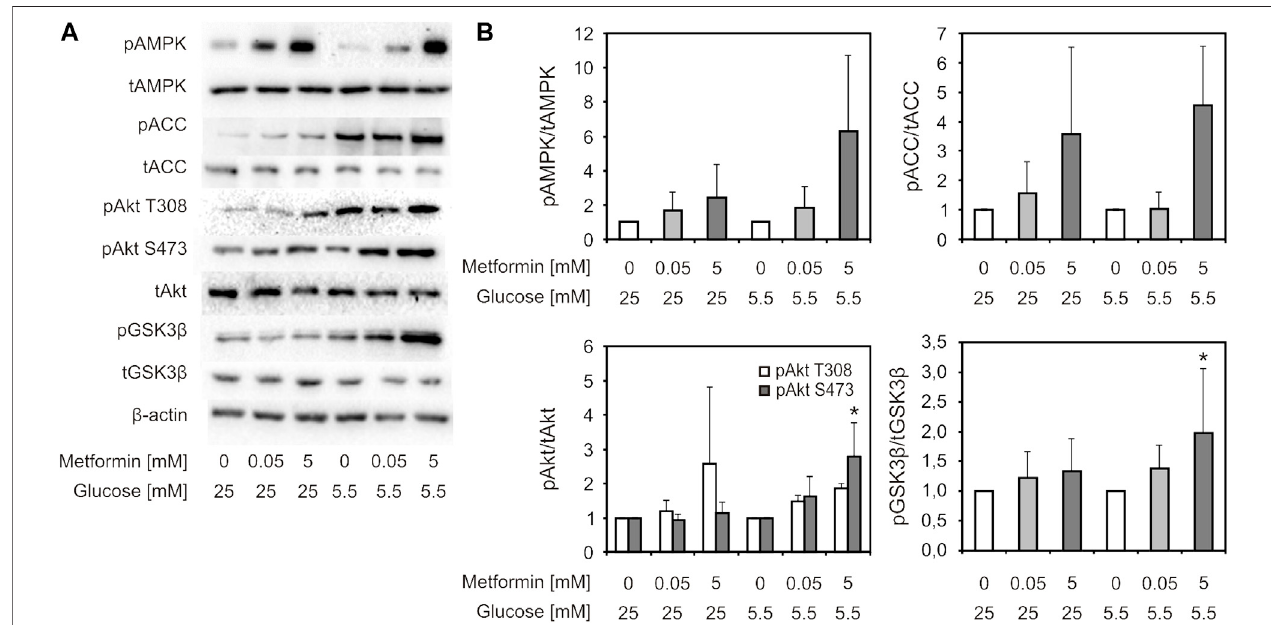
FIGURE 5 | AMPK and Akt signaling pathways were activated by suprapharmacological, but not therapeutic metformin concentration. C2C12 cells were treated with 50 µM or 5 mM metformin for 24 h. Representative immunoblot analysis of proteins of interest — phosphorylated and total forms (pAMPK Thr172, AMPK, pAkt Ser473, pAkt Thr308, Akt, pGSK3 β Ser9, GSK3 β , pACC Ser79, ACC, β -actin) of one of three indipendent experiments with similar results (A) . Densitometry data (B) is presented as fold change ±SD, compared to untreated control set to 1. Protein levels were normalised to β -actin, and phosphorylated protein levels were expressed relative to total protein level. * p < 0.05 compared to control, number of independent experiments n ≥